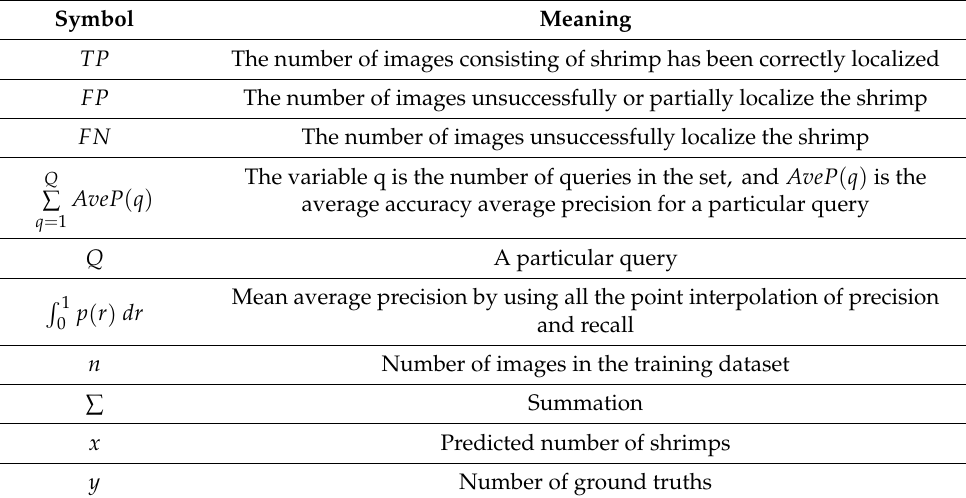
Table 4. List of